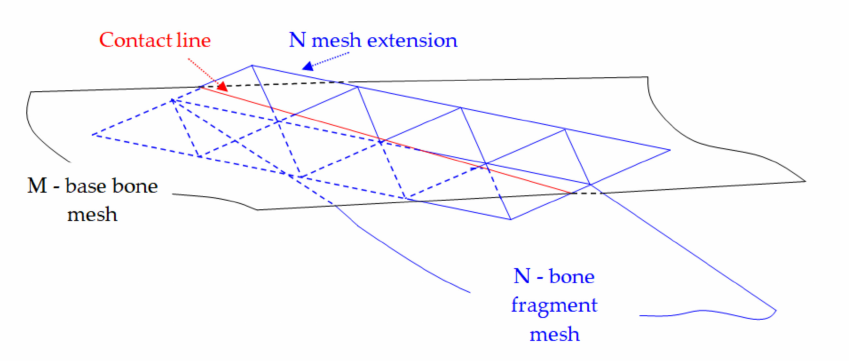
Figure 7. Extended network boundary for cutting in three-dimensional